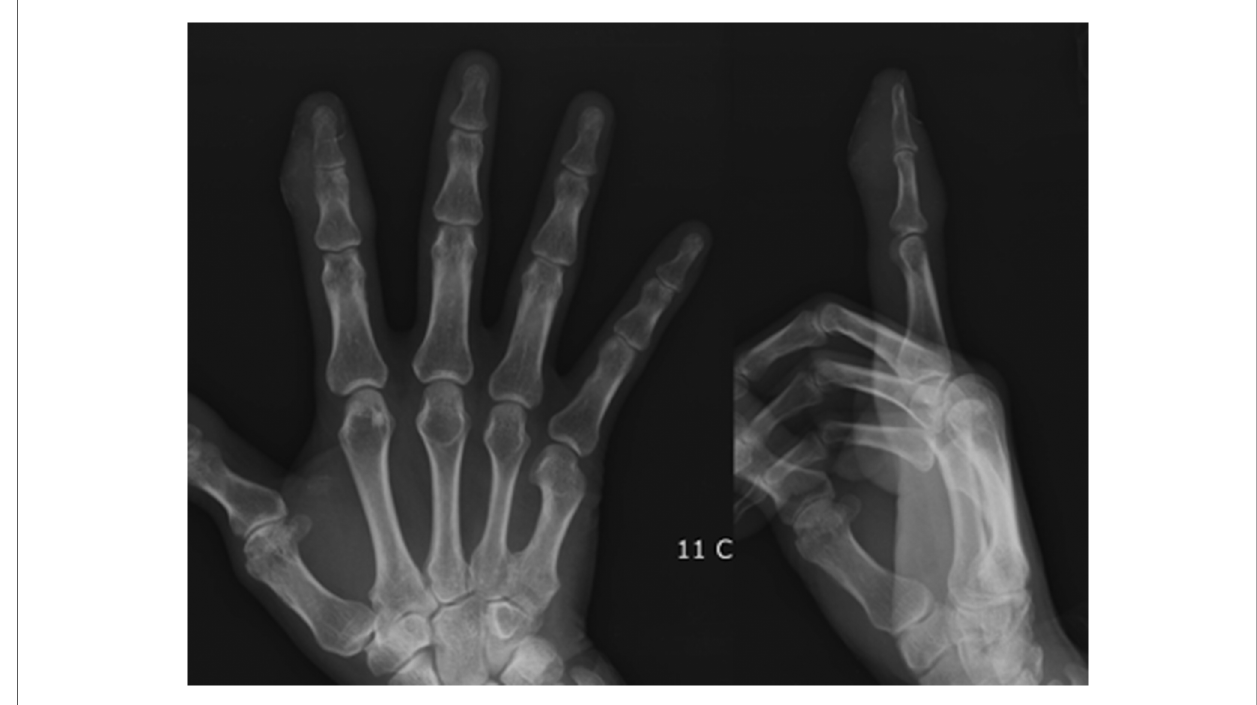
FIGURE 2 Preoperative x-ray of the right index fi nger depicting soft tissue swelling at the distal interphalangeal joint.